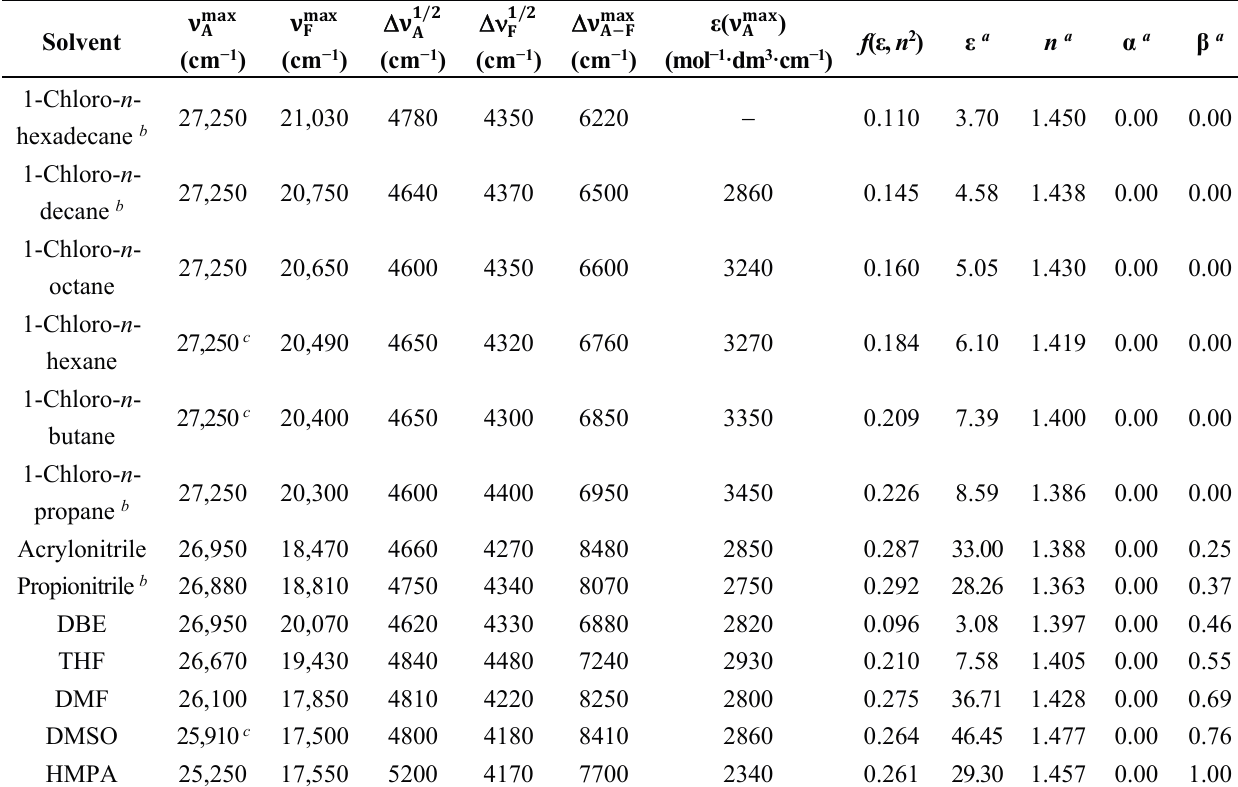
Table 1. Absorption and emission spectral properties of 6AC (1 × 10 − 4 mol dm − 3 ) in aprotic hydrogen-bond forming solvents and in 1-chloro- n -propane (non-specifically interacting